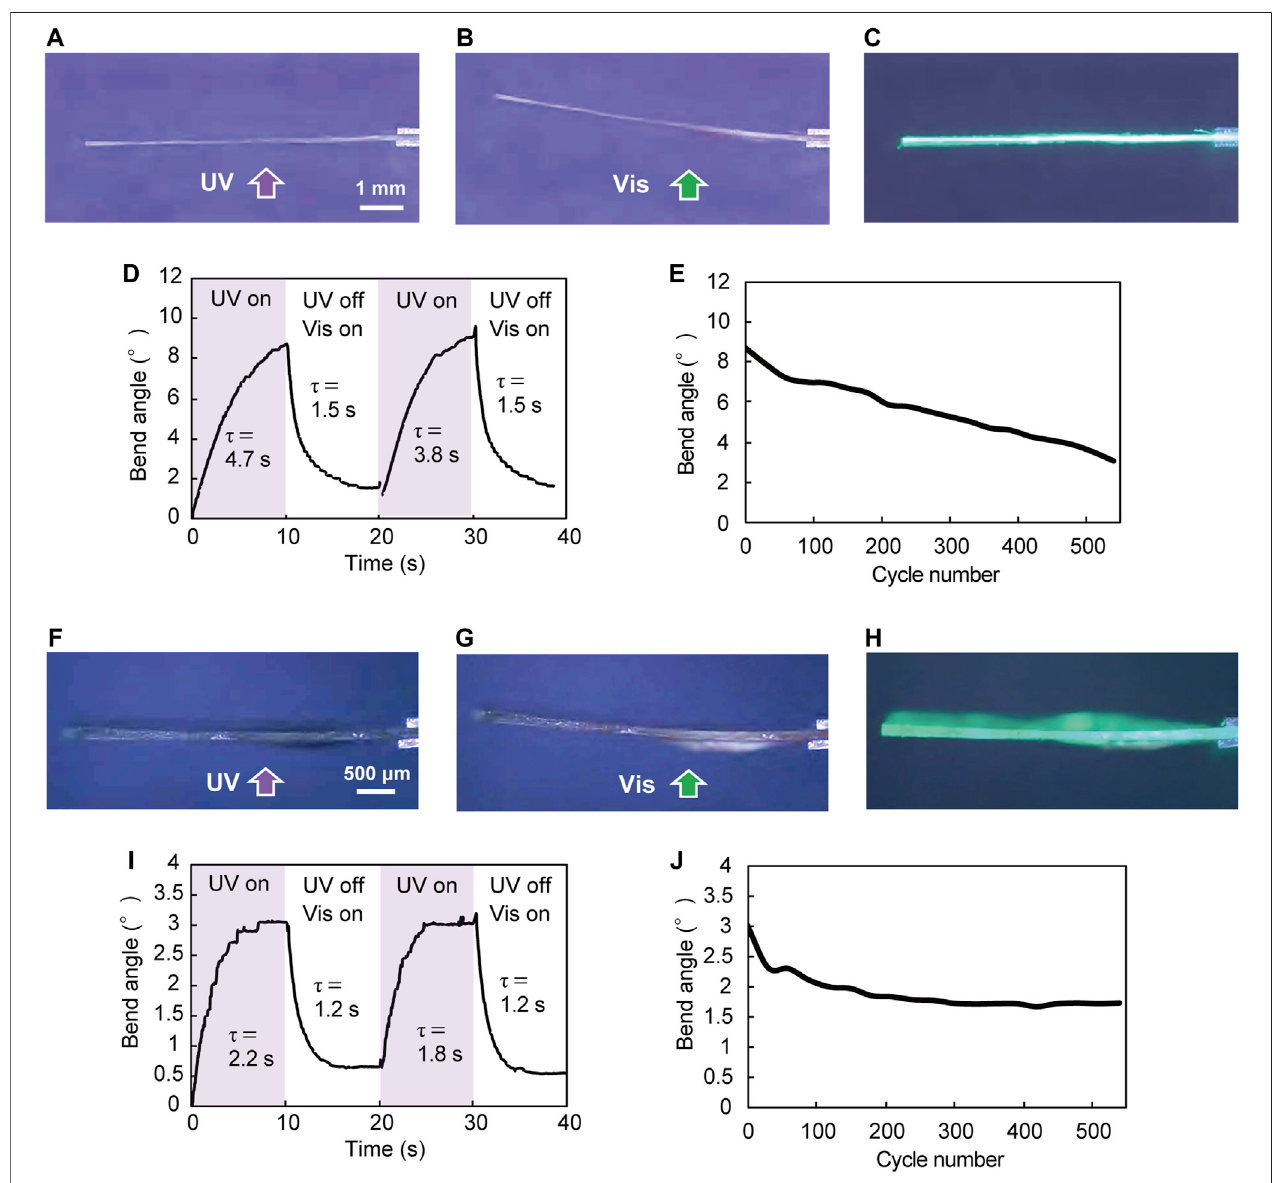
FIGURE3| Photomechanicalbendingofhybrid fi lmsuponalternateirradiationwithUV-LED(365 nm,180 mW cm − 2 ,spotdiameter8 mm)for10 sandvisiblelight (530 nm,10 mW cm − 2 )for10s. (A – E) Photomechanicalbendingofasiliconepolymerhybrid fi lm(8.6 mmlong × 3.7 mmwide × 100 μ mthick)( SupplementaryMovie S1 ). (A – C) UV irradiation of the fi lm from the lower side, and side view of photomechanical bending of the fi lm (A) before, (B) after UV irradiation for 10 s, and (C) subsequent illumination with visible light for 10 s. (D) Time dependence of bend angle (two cycles) and (E) repeatability of the reversible bending over 550 cycles. (F – J) Photomechanical bending of a UV-cured resin hybrid fi lm (7.0 mm long × 3.0 mm wide × 126 μ m thick) ( Supplementary Movie S2 ). (F – H) UV irradiation of the fi lmfromthelowerside,andsideviewofphotomechanicalbendingofthe fi lm (F) before, (G) afterUVirradiationfor10 s,and (H) subsequentilluminationwithvisiblelight for 10 s. (I) Time dependence of bend angle (two cycles) and (J) repeatability of the reversible bending over 550 cycles.